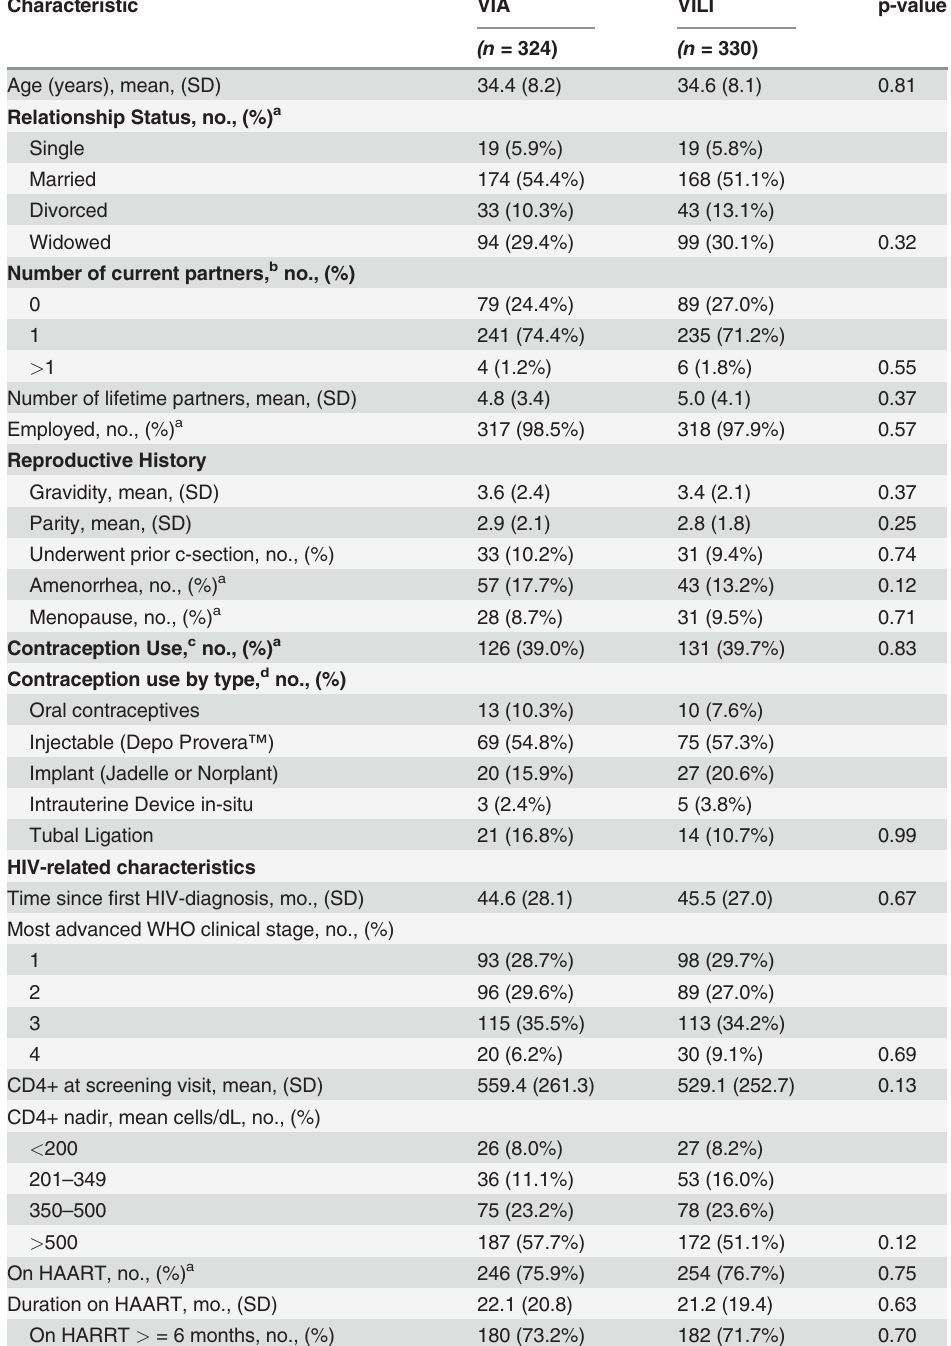
Table 1. Baseline demographic and clinical characteristics of HIV-infected women randomized to cer- vical cancer screening with Visual Inspection with Acetic Acid (VIA) or Visual Inspection with Lugol's Iodine